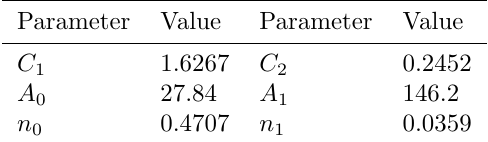
Table 8: Model parameters for outer jib